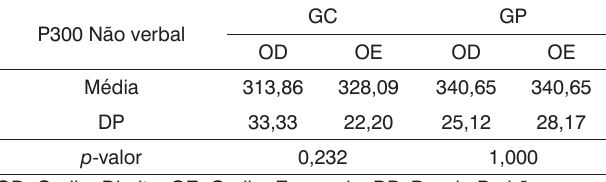
Tabela 1. Média, desvio-padrão e p -valor dos valores de la - tência (em ms) para a onda P300 (estímulo não verbal) nos